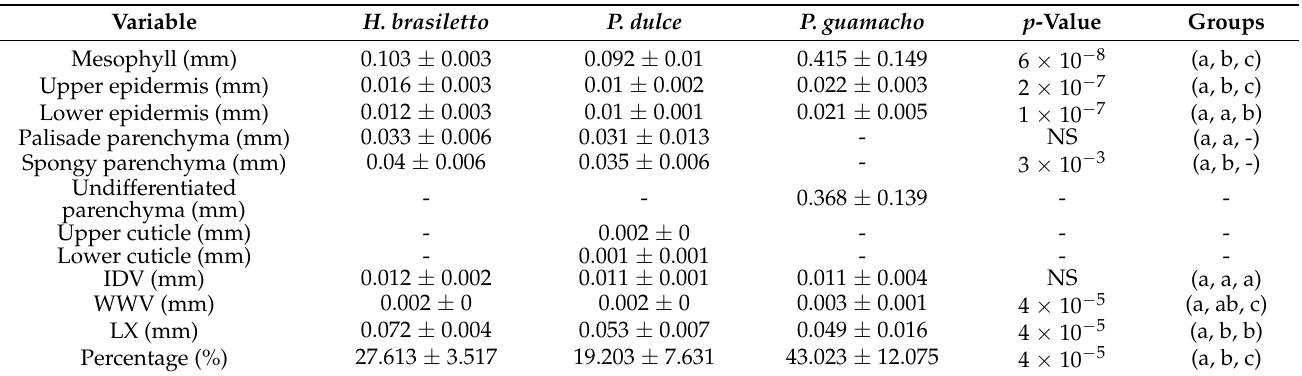
Table 3. Anatomical measurements of the leaf blade of the nurse tree species H. brasiletto, P. dulce , and P. guamacho